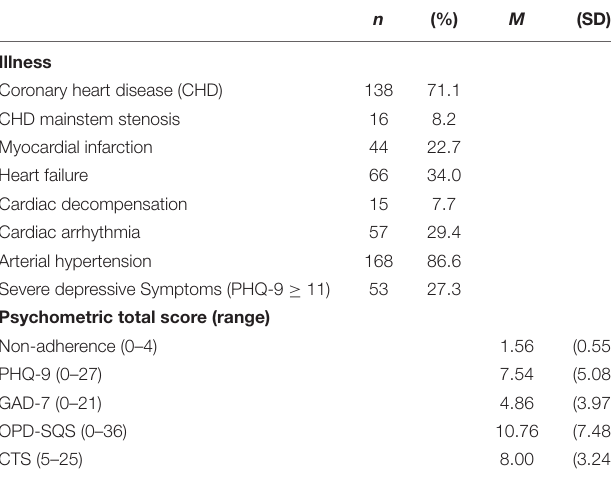
TABLE 2 | Diagnosed illnesses and psychometrics properties of the participants in this study.